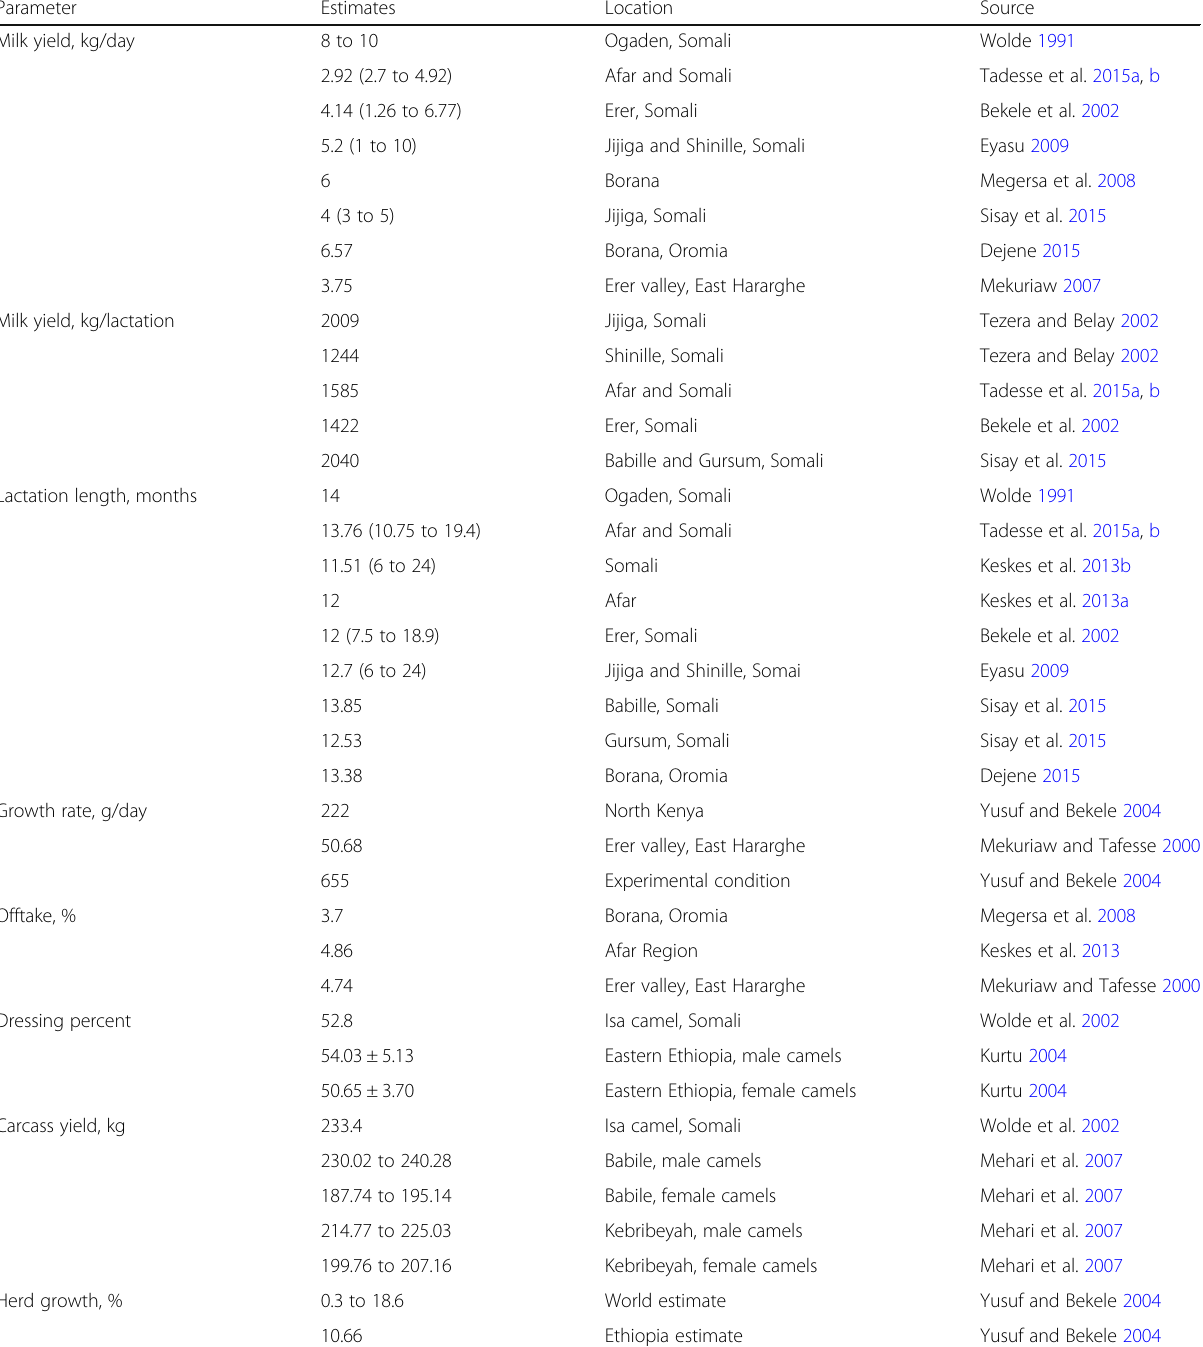
Table 3 Estimates of productive performance of Ethiopian camel ecotypes